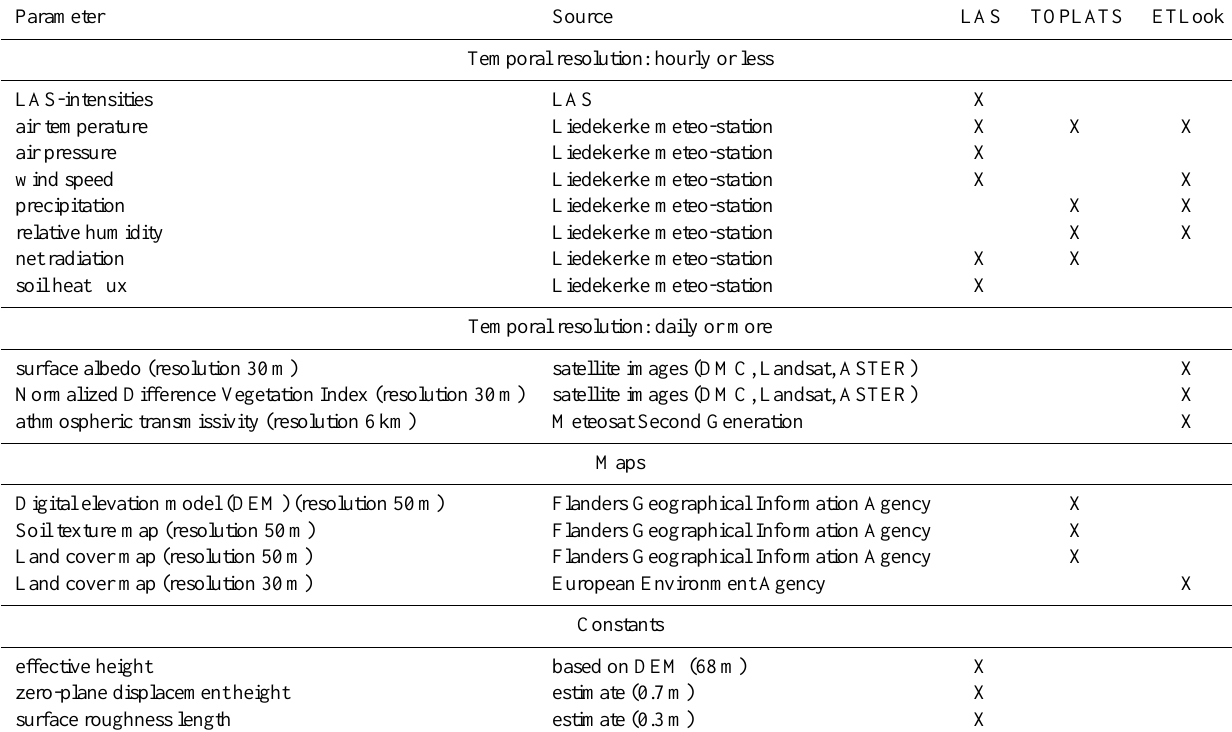
Table 1. Input data for the three different techniques to calculate catchment averaged latent heat